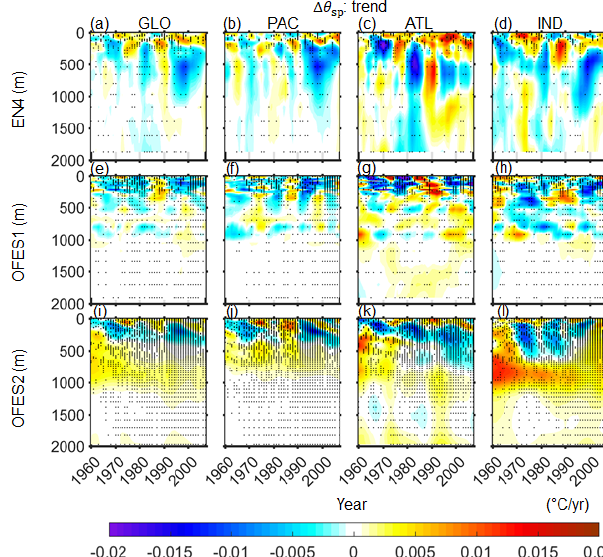
Figure 13. Depth–time pattern of the horizontally averaged poten- tial temperature change from the SP component, (cid:49)θ SP , for (left to right) the global, Pacific, Atlantic, and Indian oceans. Top to bot- tom: EN4, OFES1, and OFES2. Horizontal axis: year; vertical axis: depth in